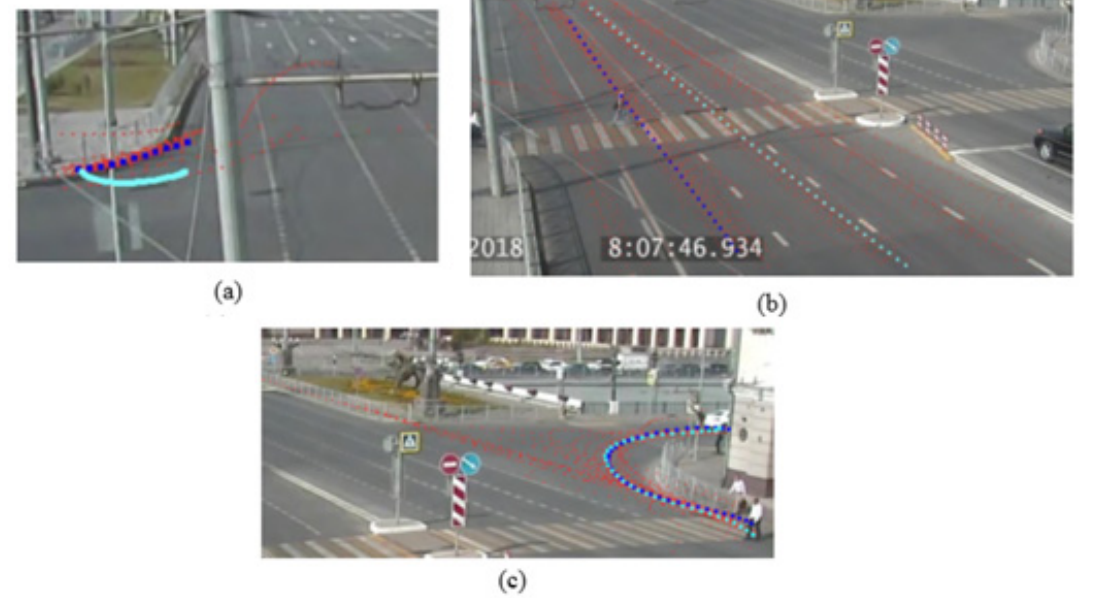
Figure 13. Results of normal trajectory classification.